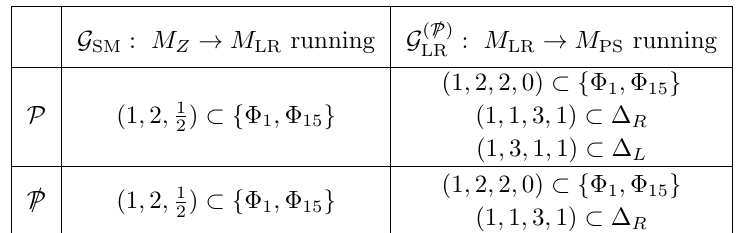
groups are given LR